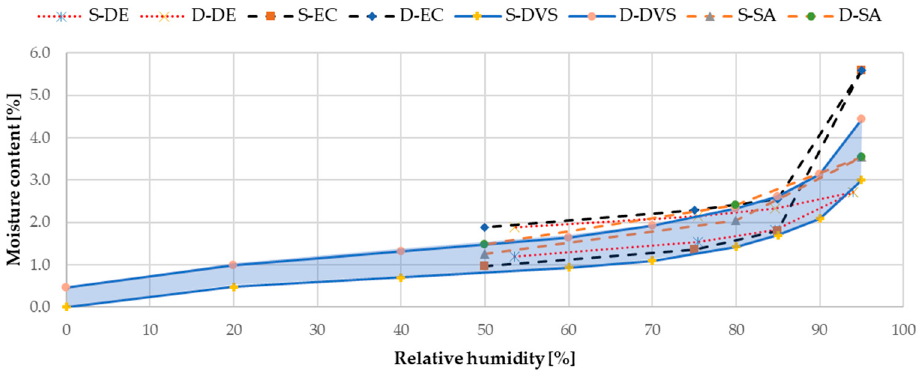
Figure 9. Sorption and desorption equilibrium points for the AC-5 sample.